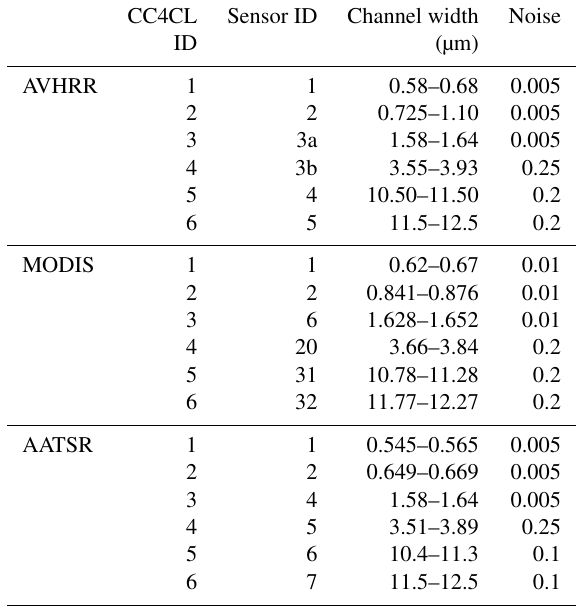
Table 1. The CC4CL AVHRR heritage dataset channel characteris- tics for AVHRR, AATSR, and MODIS. Instrument noise as applied within CC4CL is in reflectance for CC4CL channels 1–3 and in brightness temperature (K) for channels